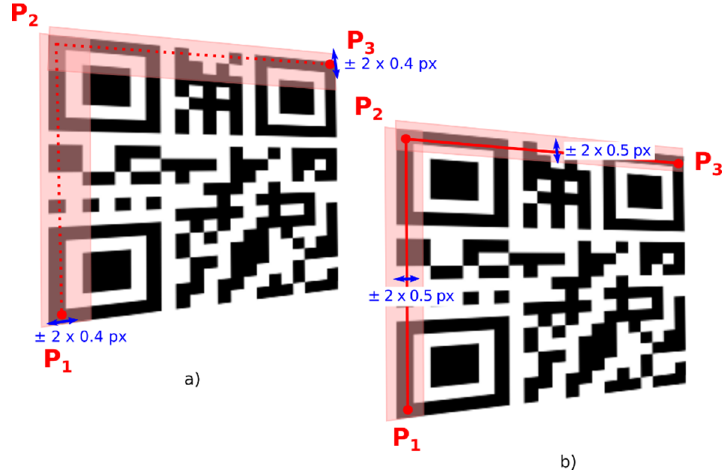
Figure 13. Refining the position of the corner points of the QR Code (alternative 1). ( a ) refining the position of the points P 1 and P 3 ; ( b ) refining the position of the lines P 1 –P 2 and P 2 –P